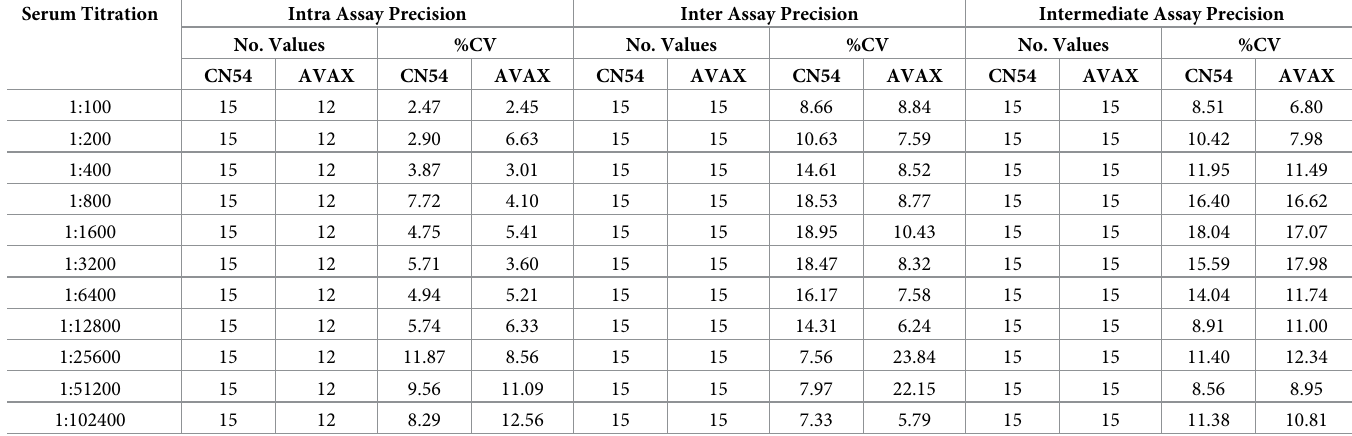
Table 2. Summary of %CV assessment determined through precision assessment for CN54 and AIDSVAX BE ELISA methodology. No. Values = the number of datapoints use for calculating precision. Serum Titration